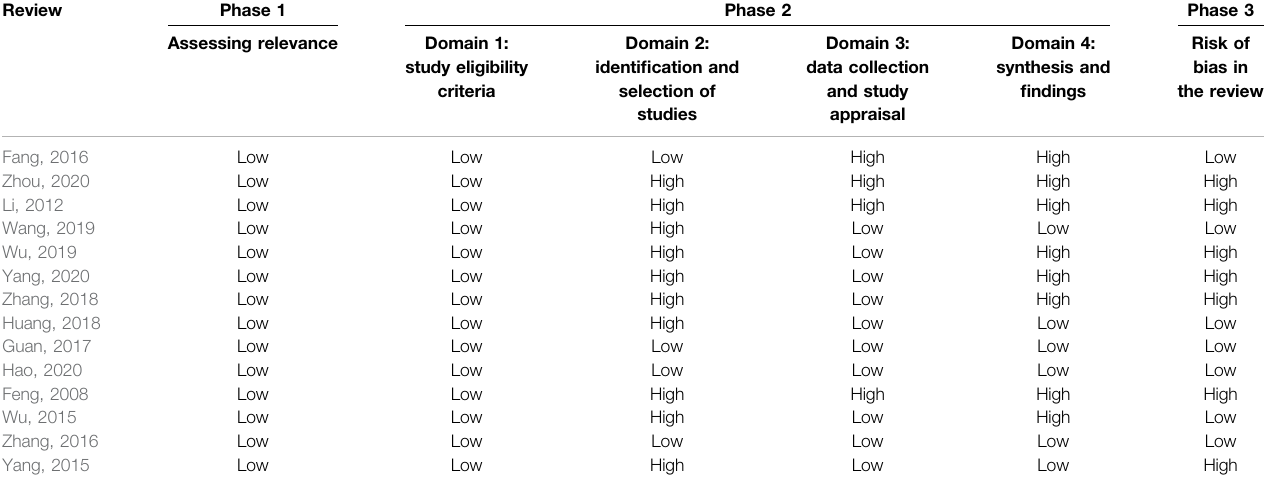
TABLE 4 | Results of ROBIS